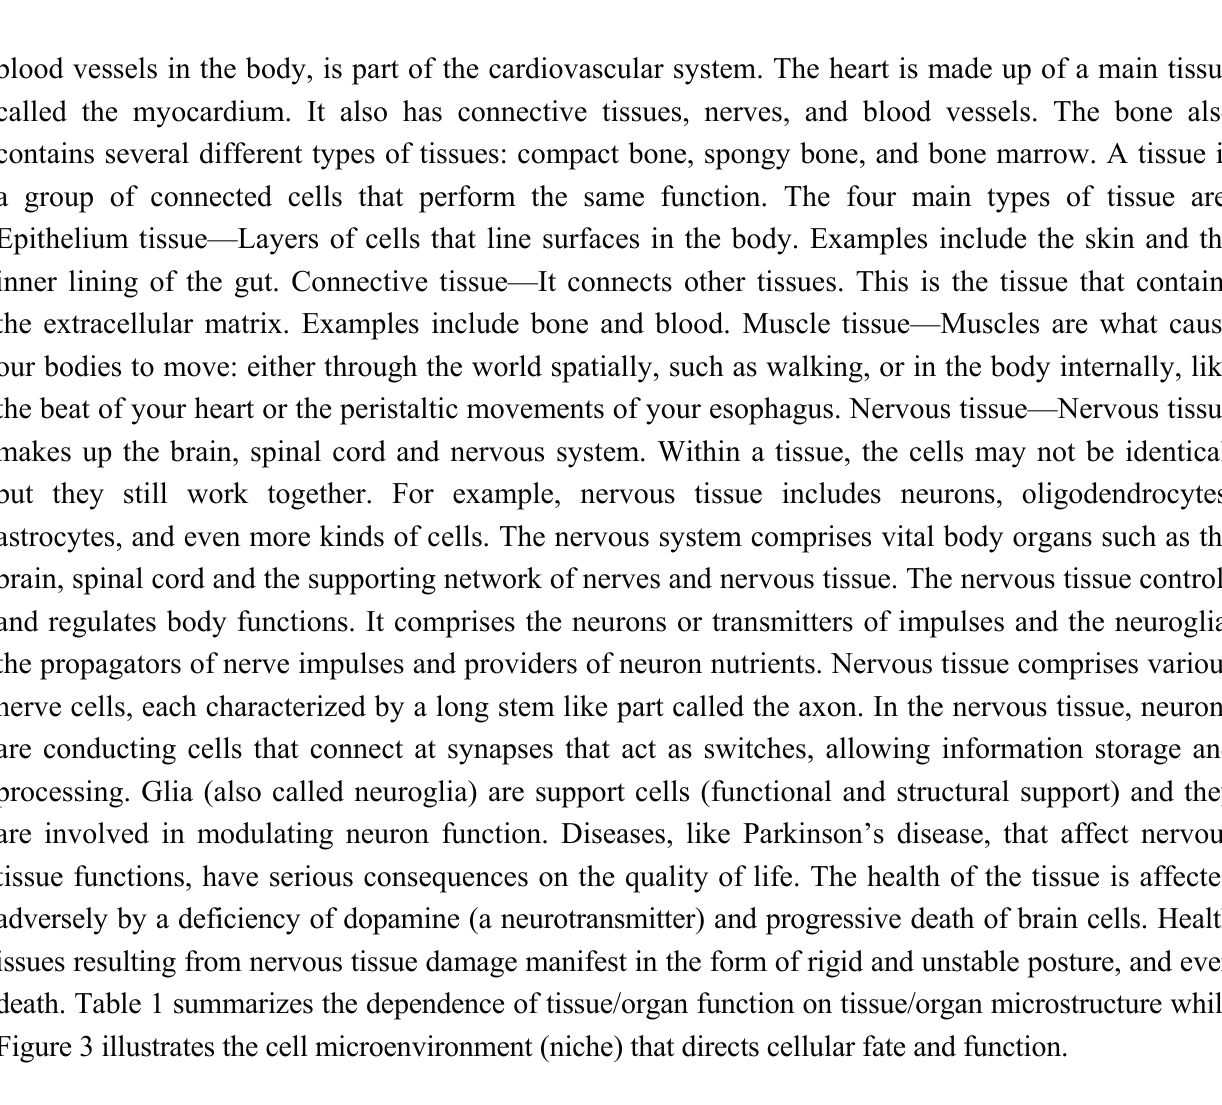
Table 1. Dependence of tissue/organ function on tissue/organ Microstructure.